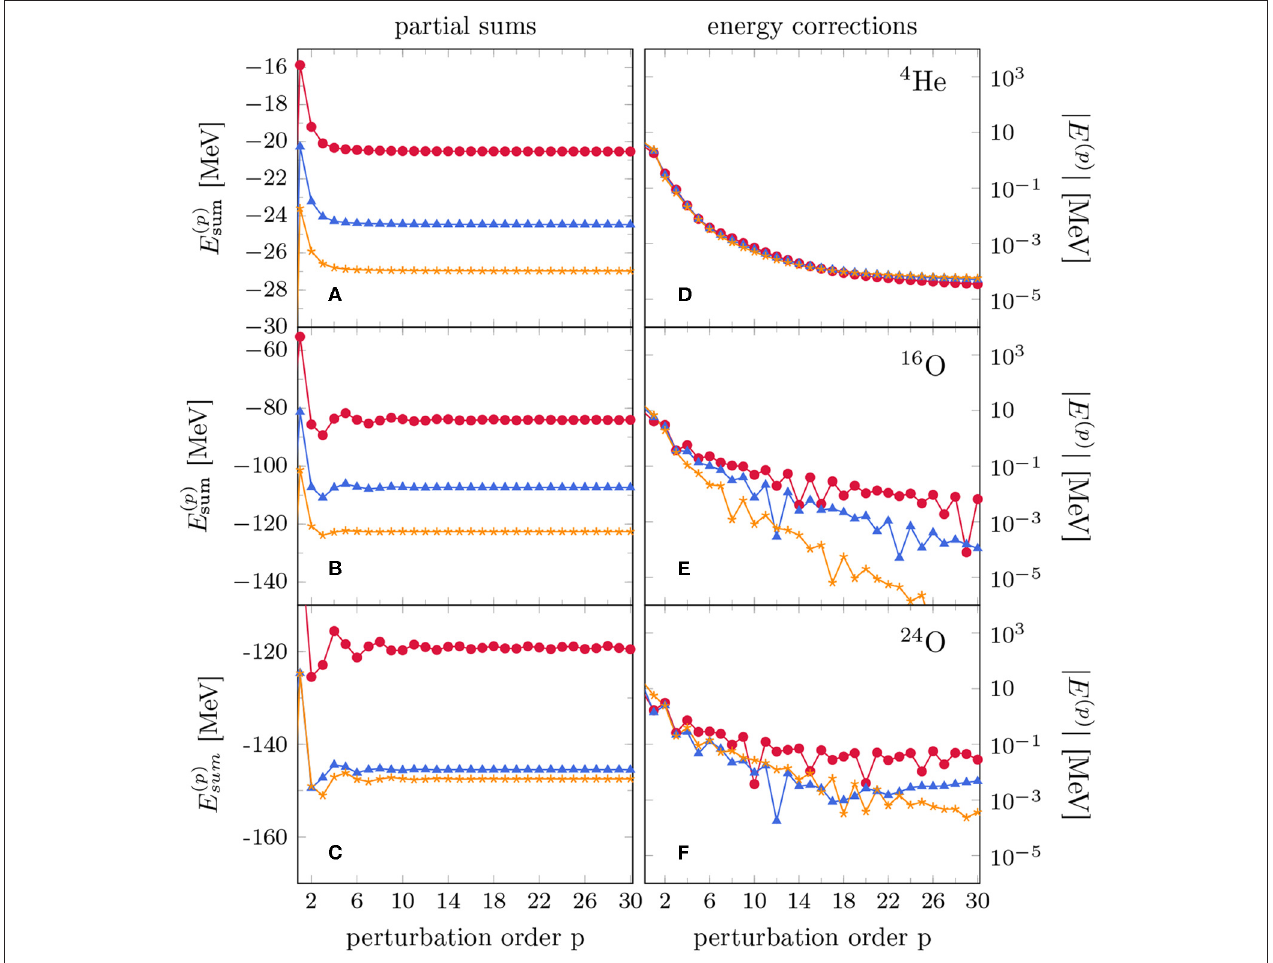
FIGURE 4 | Partial sums (A–C) and order-by-order corrections (D–F) corresponding to the ground-state energy obtained from the Hamiltonian described in section 3. Top, middle, and bottom panels correspond to 4 He ( N max = 6), 16 O ( N max = 6), and 24 O ( N max = 4), respectively. All calculations are performed setting the oscillator frequency to ¯ h ω = 20MeV. The different plot markers correspond to SRG flow parameter α = 0.02( l ),0.0625( H ), and 0.08fm 4 ( ⋆ ). Reproduced from Tichai et al. [34] under the Creative Commons CC-BY